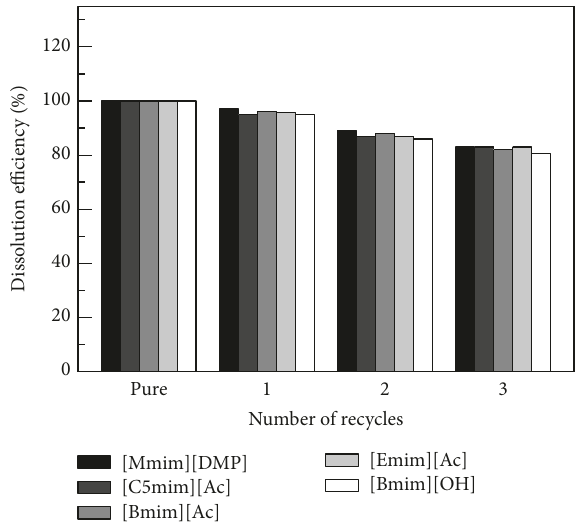
Figure 5: The dissolution efficiency of biomass in pure and recycled